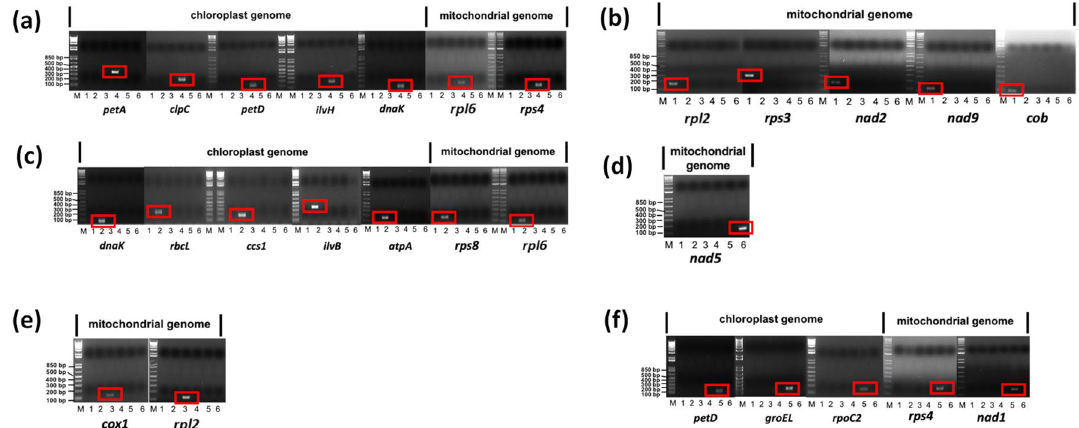
Figure 7. Development of quantitative real-time PCR based species-specific markers using SNPs of chloroplast and mitochondrial genomes. Target species are ( a ) S. confusum , ( b ) S. fulvellum , ( c ) S. horneri , ( d ) S. macrocarpum , ( e ) S. serratifolium , and ( f ) S. siliquastrum . Lane 1: S. fulvellum ; 2: S. horneri ; 3: S. serratifolium ; 4: S. confusum ; 5: S. siliquastrum ; 6: S. macrocarpum , M: DNA ladder. Full-length gels are presented in Supplementary Fig.